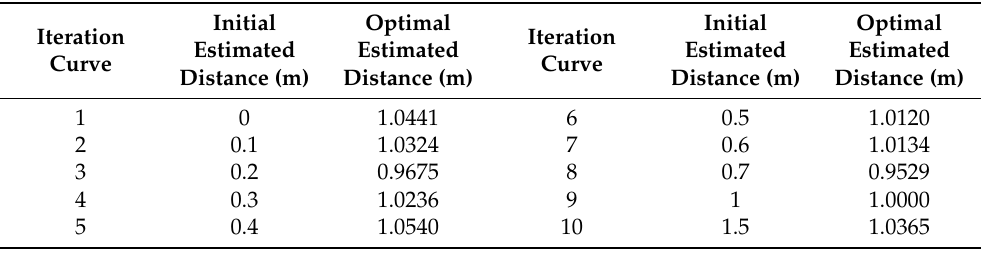
Table 4. The optimal estimated distance of near-field imaging results from different initial estimated distances of two-dimensional line